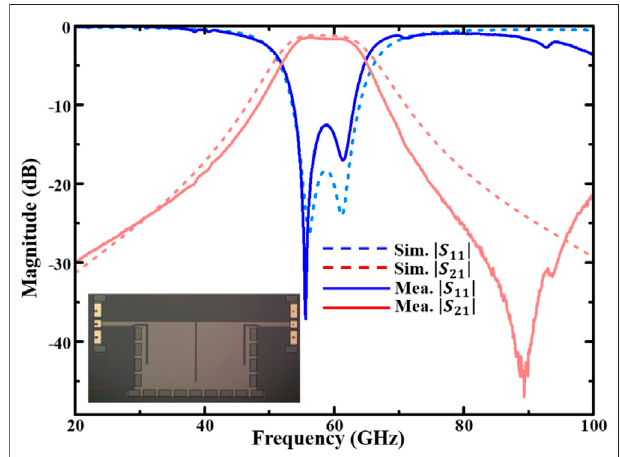
FIGURE 6 | Simulated and measured results of the proposed GaAs – based BPF.